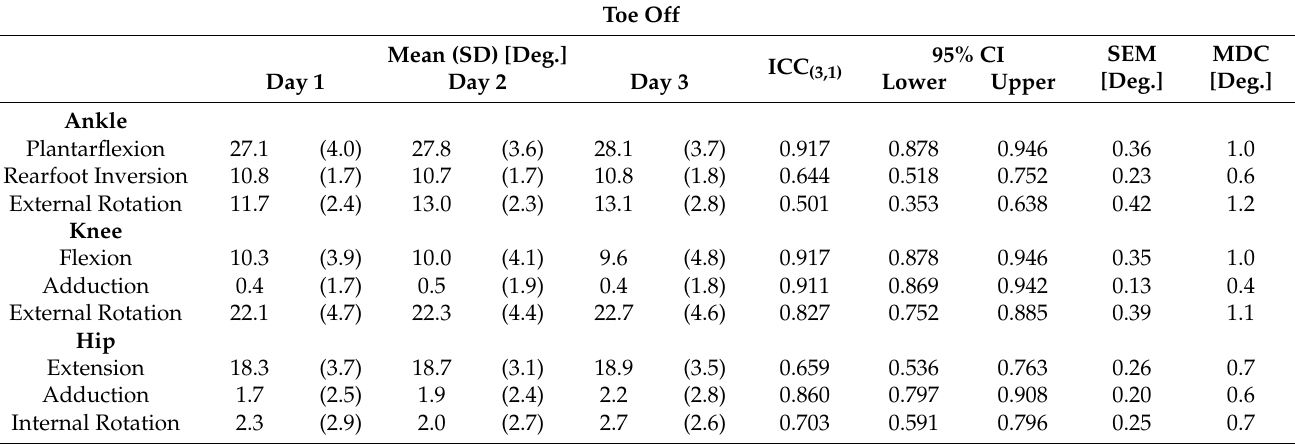
Table 5. Reliability of key kinematic metrics at toe off across three distinct sessions and three distinct speeds in 21